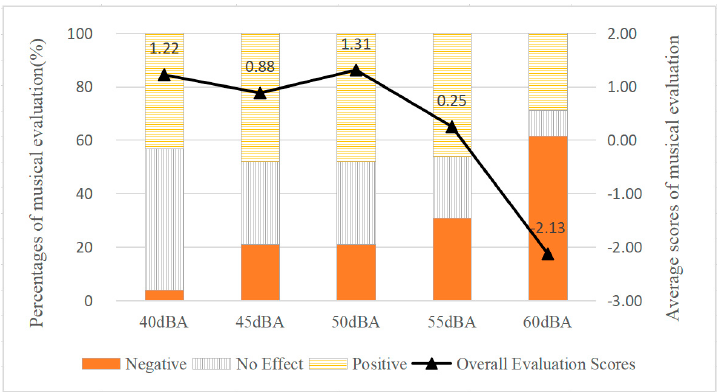
ff ect of SPL on Musical Evaluation during Figure 3. The Effect of SPL on Musical Evaluation during Communication. Figure 3. The E